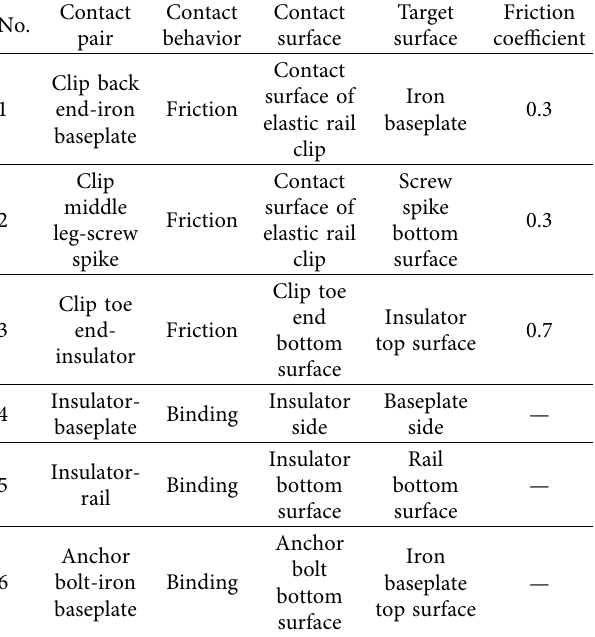
Table 2: Contact pair parameters.